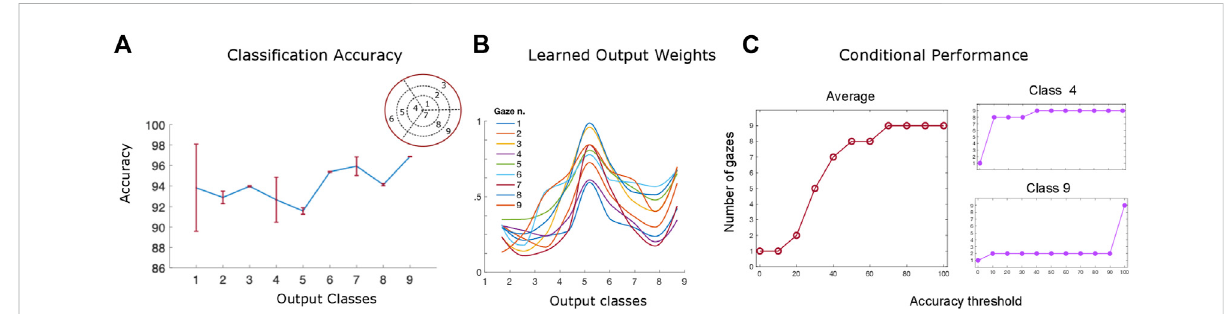
FIGURE 9 (A) The network ’ s performance (accuracy) averaged over all slant and tilt pairs belonging to each of the nine orientation classes. The red lines denotethestandarderrorofthemean(SEM)acrossalldifferentslantandtiltpairsbelongingtoeachclass (B) Thetrainedweightparametersbetween the recurrent and output layers for orientation class 5, showing the emergence of an invariant slant and tilt representation across all nine different gaze directions (C) The algorithm ’ s performance as a function of the number of gaze-variant disparity maps used as an input averaged across classes (left) and for the orientation classes 9 and 4